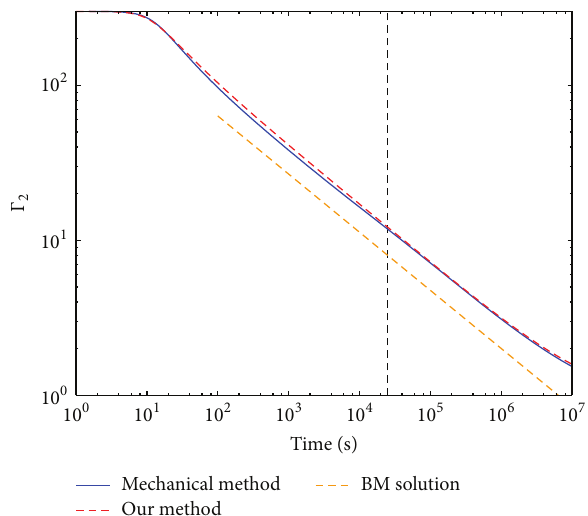
Figure 4: Comparison of the two methods used in solving the temporal evolution of Γ 2 in the 𝑒 + 𝑒 − wind model. The initial parametervaluesare 𝐸 𝐾, iso = 8.0×10 52 erg, Γ 2,0 = 150 , 𝑛 0 = 0.1 cm −3 , = 10 4 , and 𝐵 = 2 × 10 14 G. The thick dashed orange line Γ 4 NS represents the BM solution (schematic); that is, Γ ∝ 𝑡 3/8 obs and the vertical dashed line denote the position of 𝑇 sd .